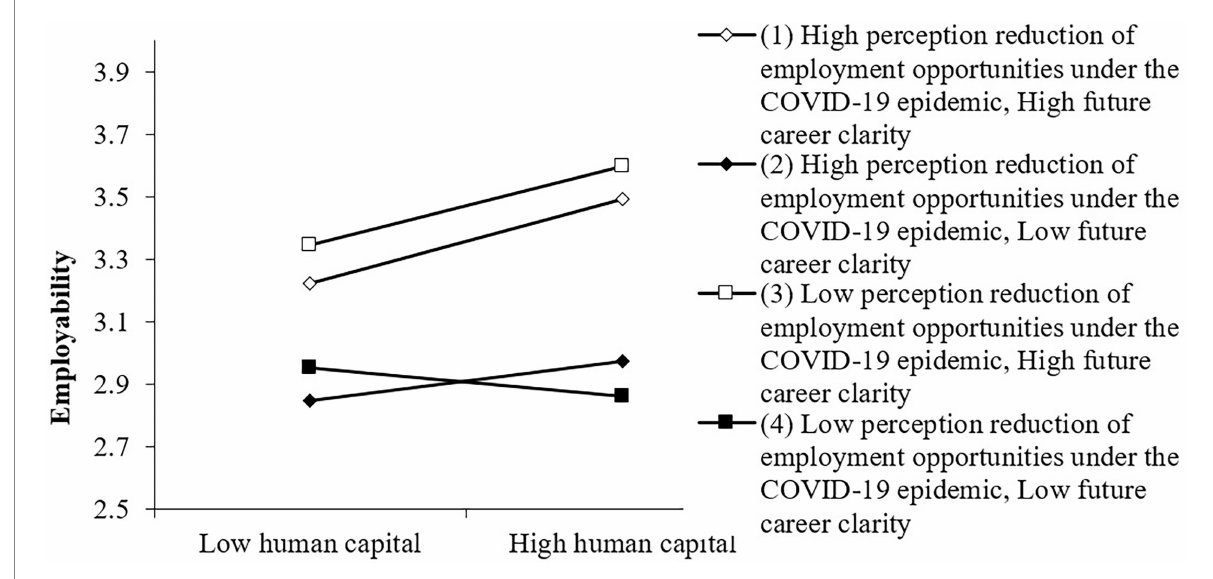
FIGURE 4 The joint moderating effect of perception reduction of employment Opportunities under the COVID-19 epidemic and future career clarity on human capital and Employability.